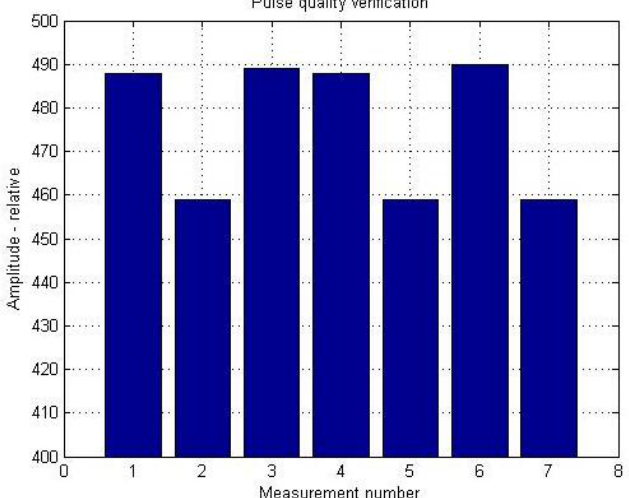
Figure 8. Verifying of pulse‘s quality by regressive control of their major frequencies maximums derived from